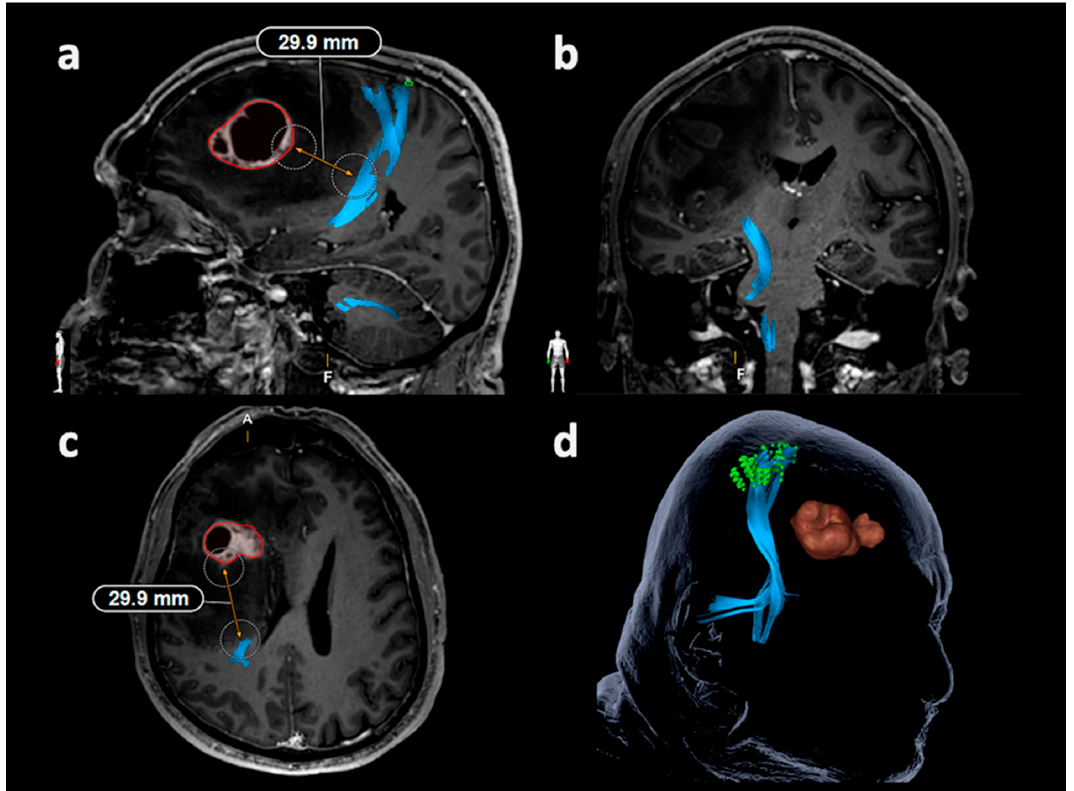
Figure 1. Measurement of the lesion-to-tract distance (LTD) in relation to the corticospinal tract (CST).